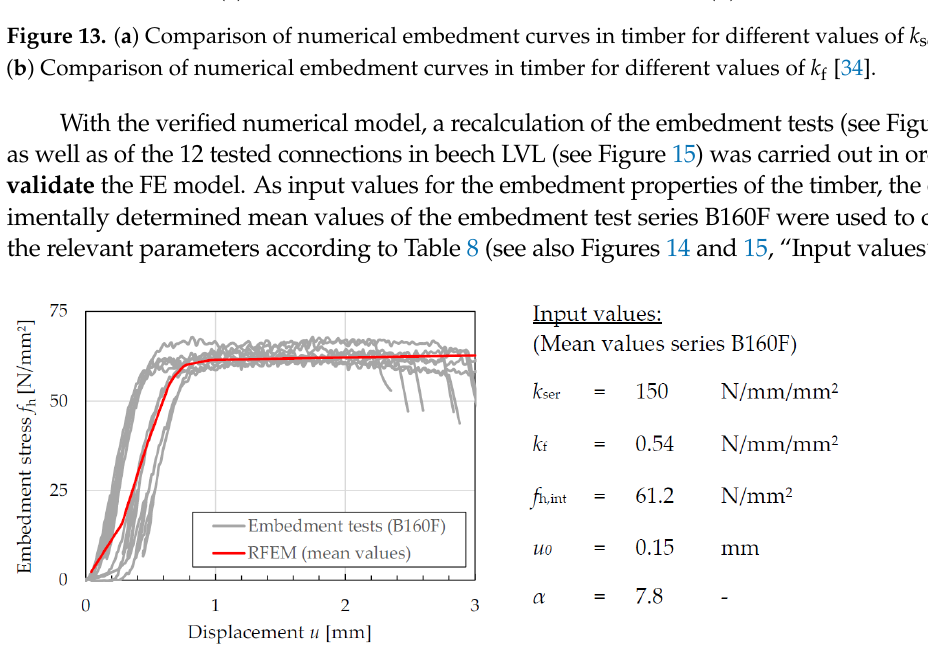
Figure 14. Experimental (“Embedment tests”) and numerical (“RFEM”) embedment curves of the test series B160F [34].